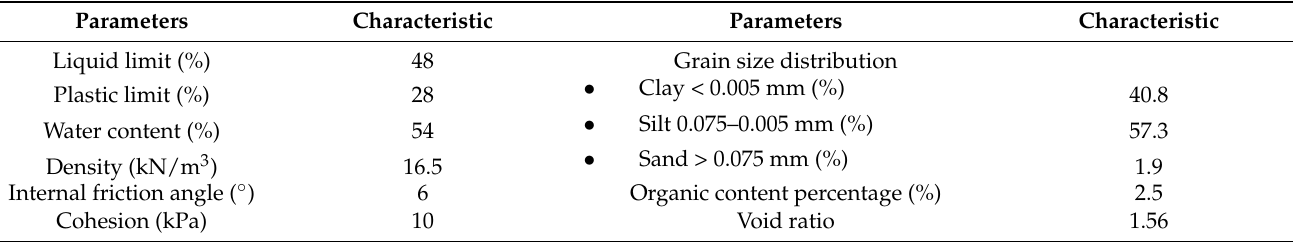
Table 1. Parameters of soft clay.